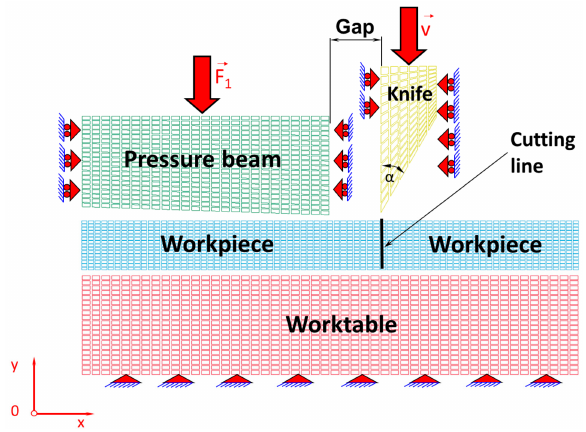
Figure 2. Discretisation into finite